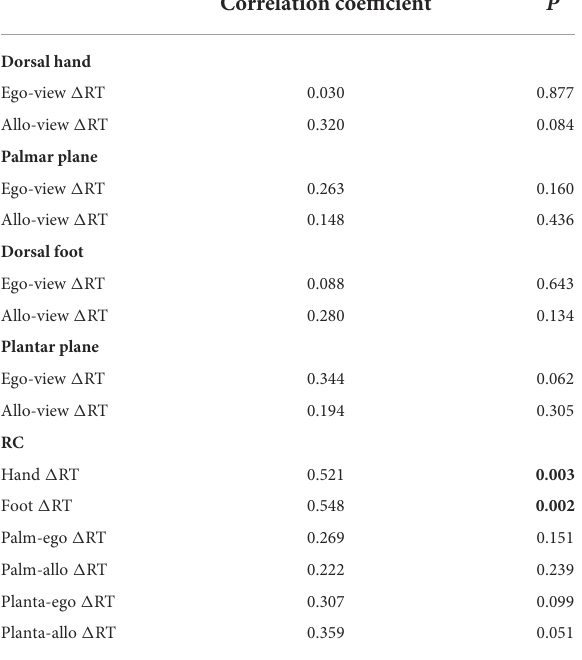
TABLE 2 Correlation between adaptive learning ability on gait and values of